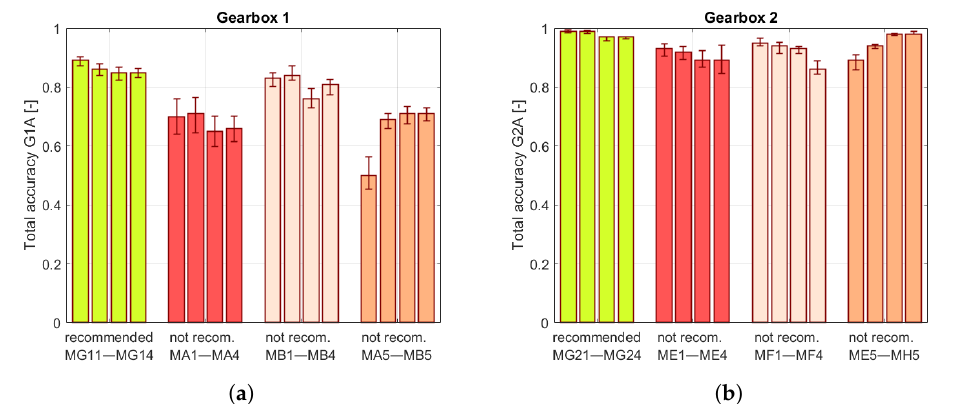
Figure 14. Total accuracies obtained for models trained on the dataset obtained for ( a ) Gearbox 1 and ( b ) Gearbox 2. The whiskers indicate minimal and maximum accuracy values.